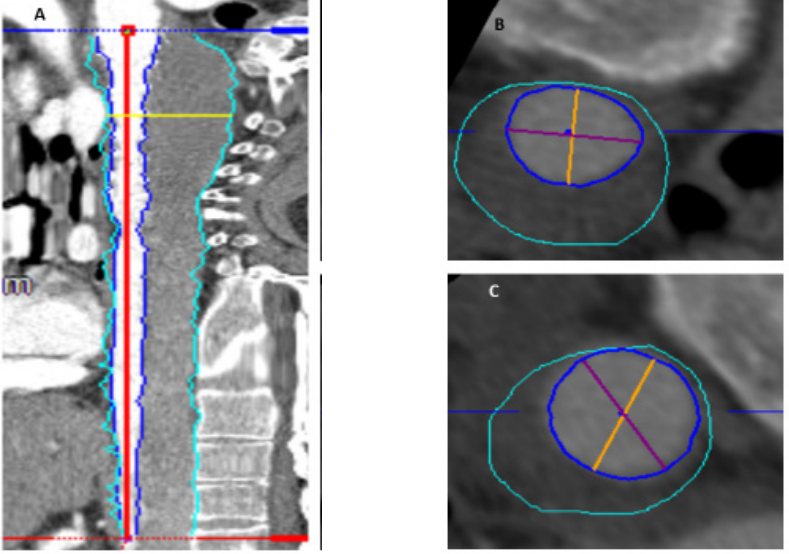
Figure 1. Thrombus volume measurements before and after the FET/CET procedure using a dedicated software. ( A ) Centerline in the true lumen, thrombus area has been marked and measured manually for each CT slice (grey area), separated from the true lumen. ( B , C ) Volume of the thrombus was measured by subtracting the true lumen from total aortic diameter.